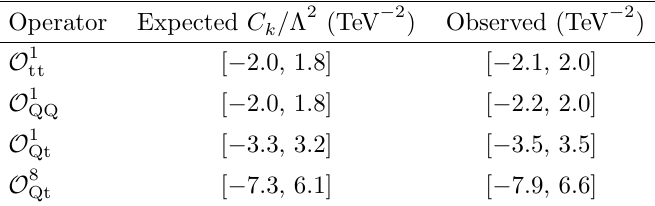
Table 5 . Expected and observed 95% CL intervals for selected coupling parameters. The intervals are extracted from upper limit on the tttt production cross section in the EFT model, where only one selected operator has a nonvanishing contribution.